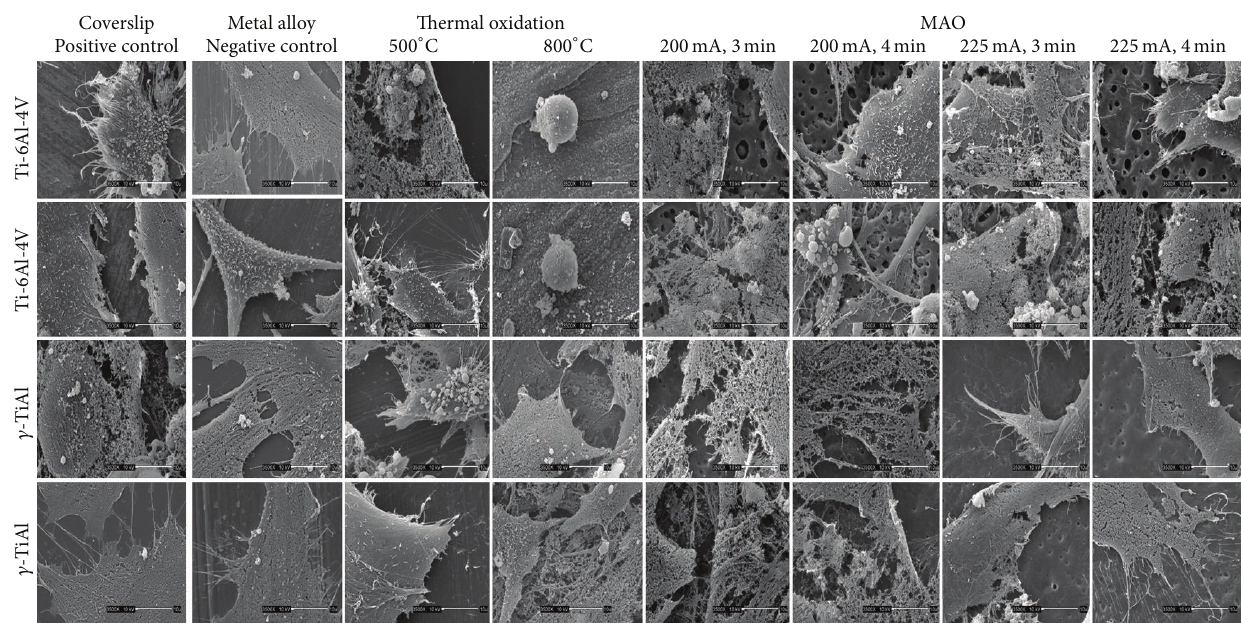
Figure 3: SEM micrographs of hFOB 1.19 cells seeded on a glass coverslip (positive control), GTi and TiV (untreated alloys), TiV5 and GTi5 (500 ∘ C), TiV8 and GTi8 (800 ∘ C), MAOTiV (200mA and 225 mA at 3 min and 4 min), and MAOGTi (200mA and 225 mA at 3min and 4 min) disks and incubated for 10 days (3 days at 33.5 ∘ C and subsequently 7 days at 39.5 ∘ C). Magnification 3500x.